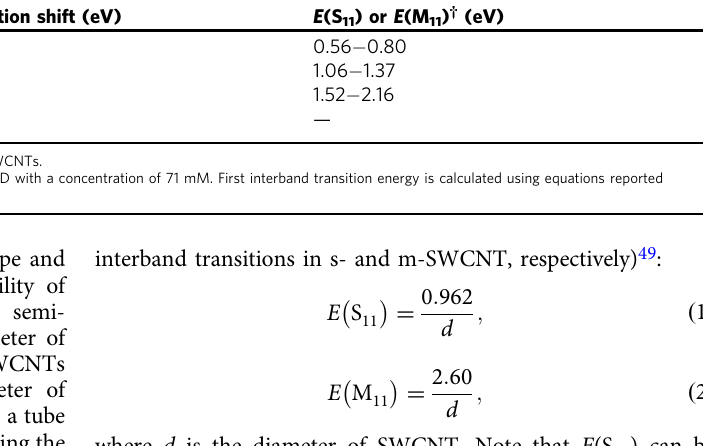
Table 1 Work function shifts upon doping of TBD according to the conducting type of SWCNTs measured in air. Sample Work function shift (eV) E (S 11 ) or E (M 11 ) † (eV) s-SWCNT ( d = 1.2 − 1.7 nm) − 0.74 0.56 − 0.80 s-SWCNT ( d = 0.7 − 0.9 nm)